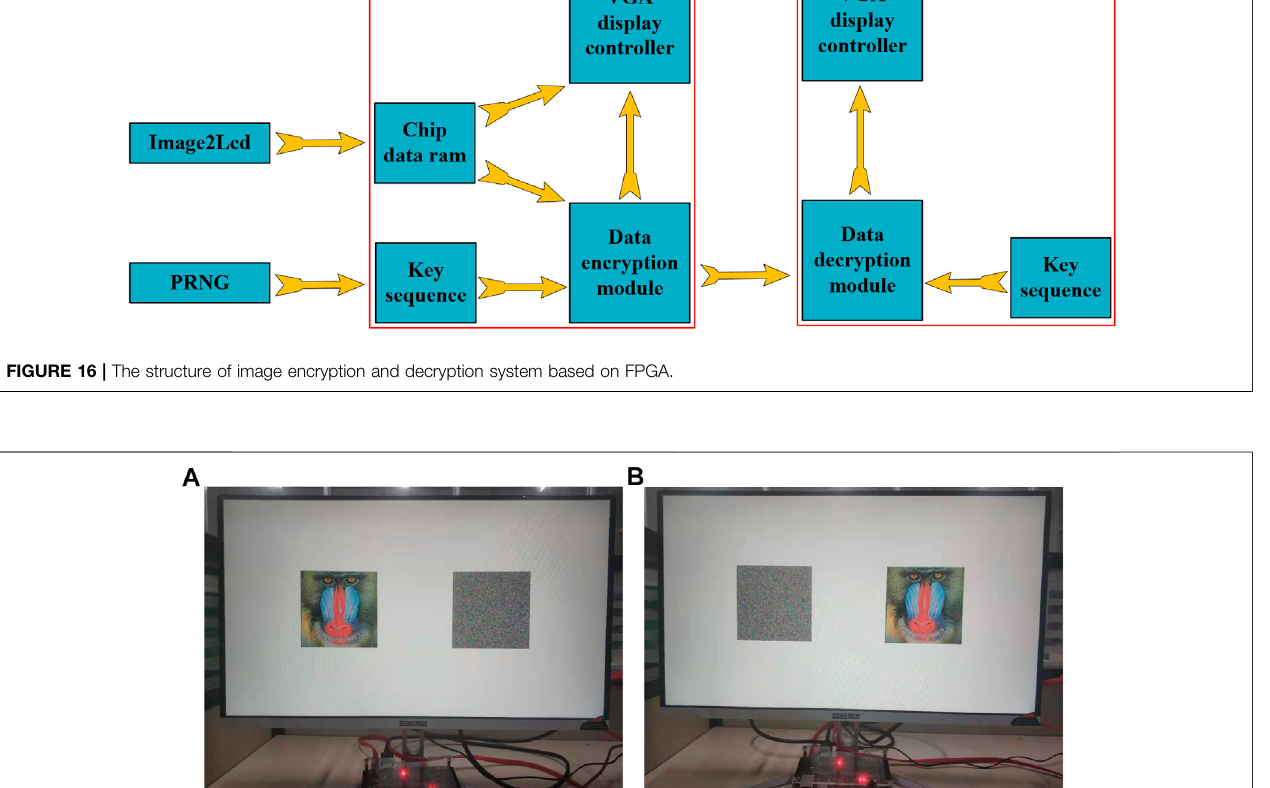
Frontiers in Physics |